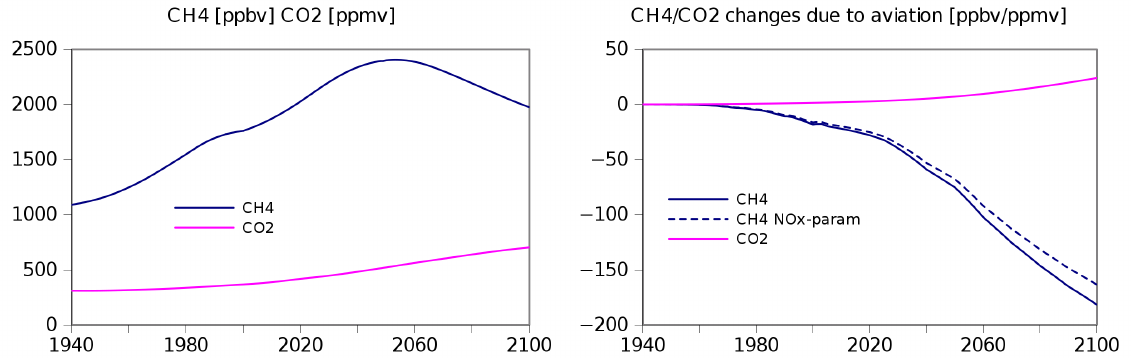
Fig. 4. On the left, evolution of methane and CO 2 according to the A1B scenarios. On the right, calculated methane reduction due to aviation NO x emissions for the A1B scenario with (dashed line) and without (bold lines) NO x plume parameterization, and CO 2 changes according to the A1(i)